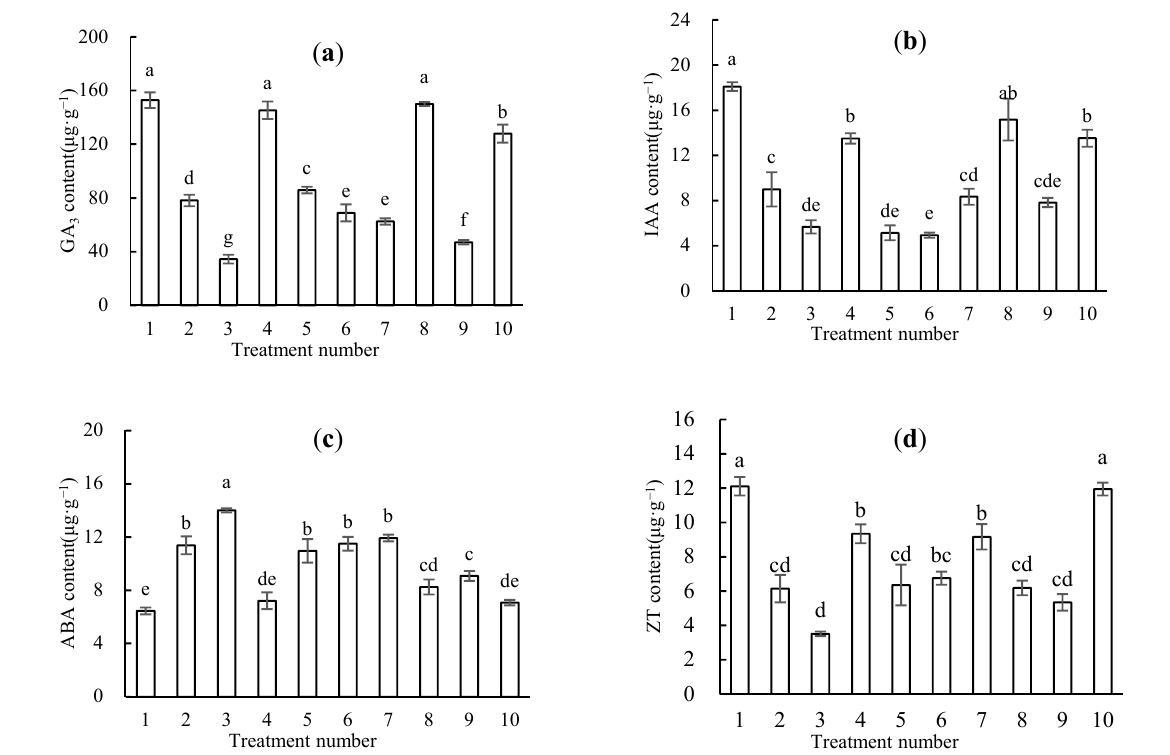
Figure 3. The effects of PGRs on GA 3 ( a ), IAA ( b ), ABA ( c ) and ZT ( d ) in M. wufengensis . Based on the range analysis results shown in Table 4, the concentration and times of PGR treatments had extremely significant effects on GA3, IAA, ABA, and ZT levels ( p < 0.01), and the effects of both variables were greater than that noted for the variety of PGRs, which only had a significant effect on IAA content ( p < 0.05). Among them, the influence of PGR concentration on GA3, IAA and ZT content was greater than that noted for the number of applications, and the influence of ZT content was less than that noted for the number of applications.